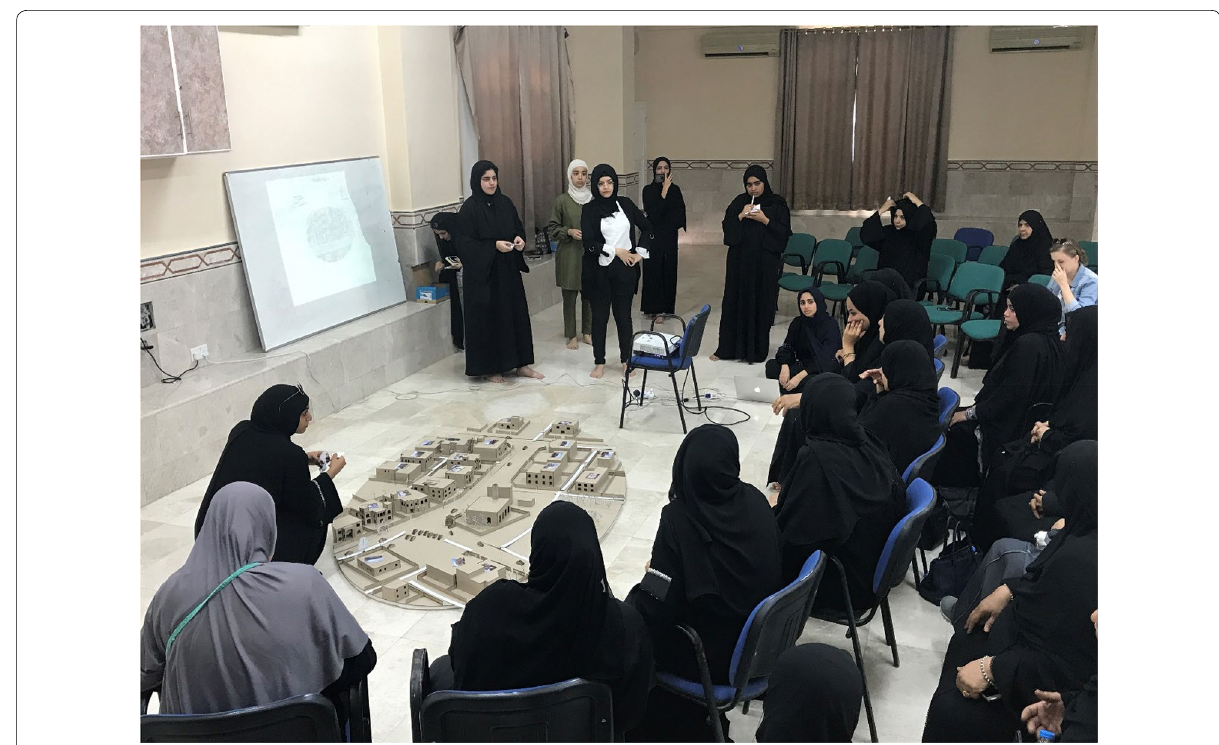
Fig. 9 Women’s workshop about the Al Ghubrah neighborhood in 2019. Residents used the replica model to input urban elements such as sidewalks and zebra crossings, appropriately responding to the predetermined goals of walkability. They were also given the freedom to use ‘comment cards’ to address non-physical spatial cues and cultural norms of the area that could be considered when redesigning the area, as well as situations not forecasted by the planned workshop